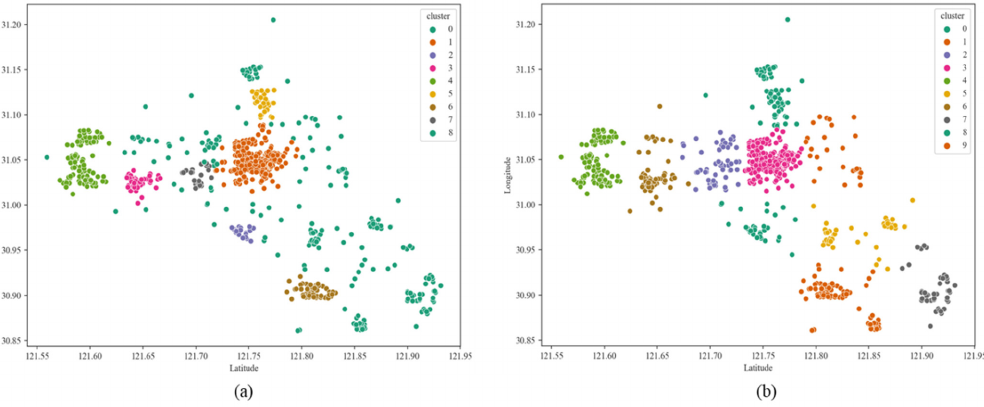
Figure 19. Clustering results: ( a ) DBSCAN analysis on the “PDIA-SL” dataset; ( b ) K-means analysis on the “PDIA-SL” dataset.